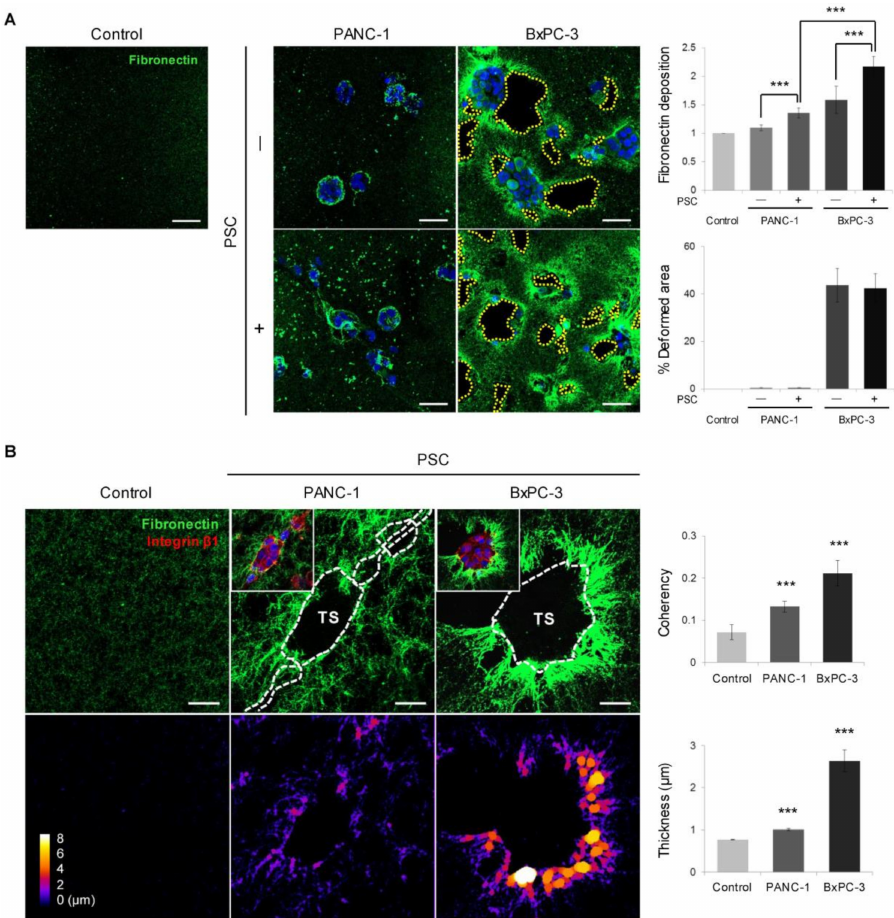
Figure 5. Di ff erential remodeling of the fibronectin matrix between PANC-1 and BxPC-3 cells. ( A ) E ff ects of PSC co-culture on the expression of fibronectin in TSs. Scale bar: 50 µ m. ( B ) Changes in fibronectin structure and organization with respect to coherence and thickness. Scale bar: 20 µ m. Control: cell-free matrix. TS: tumor spheroid. Three fields were imaged per experiments and more than 10 regions of interest were selected for experiment and subjected to analysis. Data were obtained from three separate independent experiments. *** p <